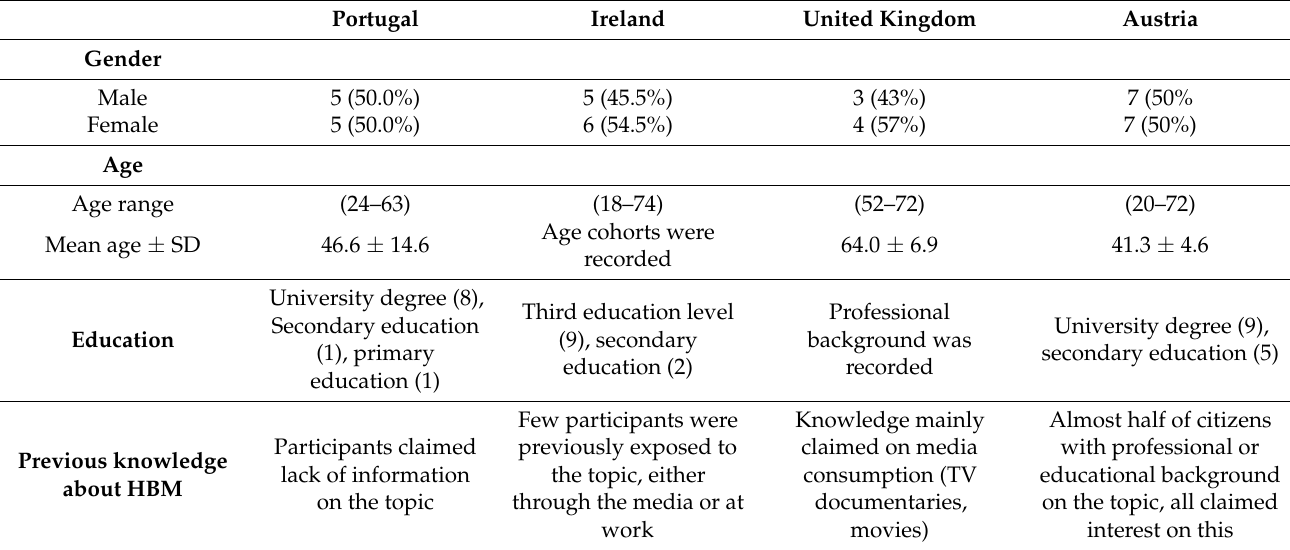
Table 2. Sample characterisation by